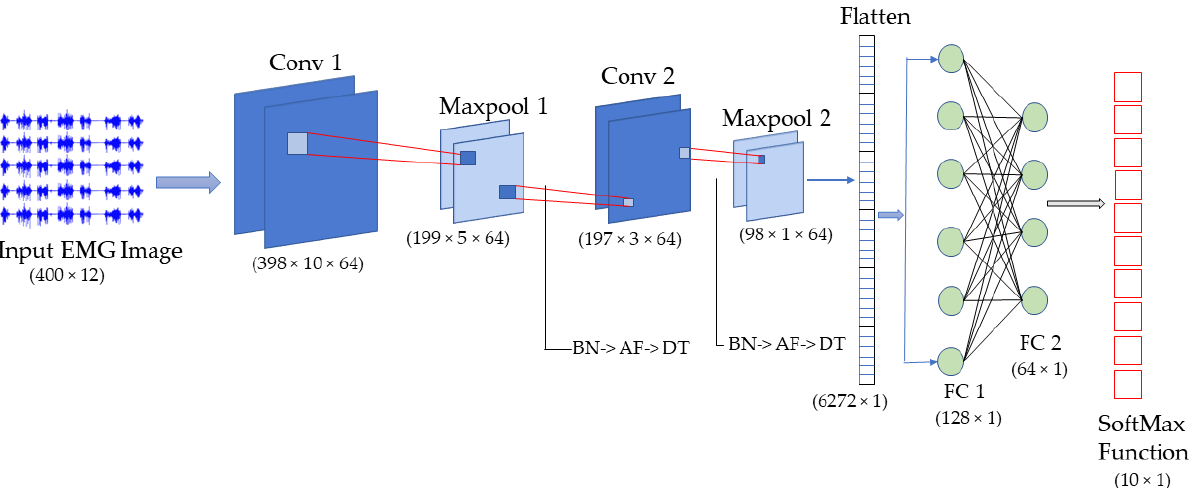
Figure 4. The architecture of the proposed CNN model with input image as obtained from 200 ms sliding window length used in the study. The hyperparameters, such as learning rate, neurons in fully connected layers, and filter size were tuned during hyperparameter tuning in each of the model.